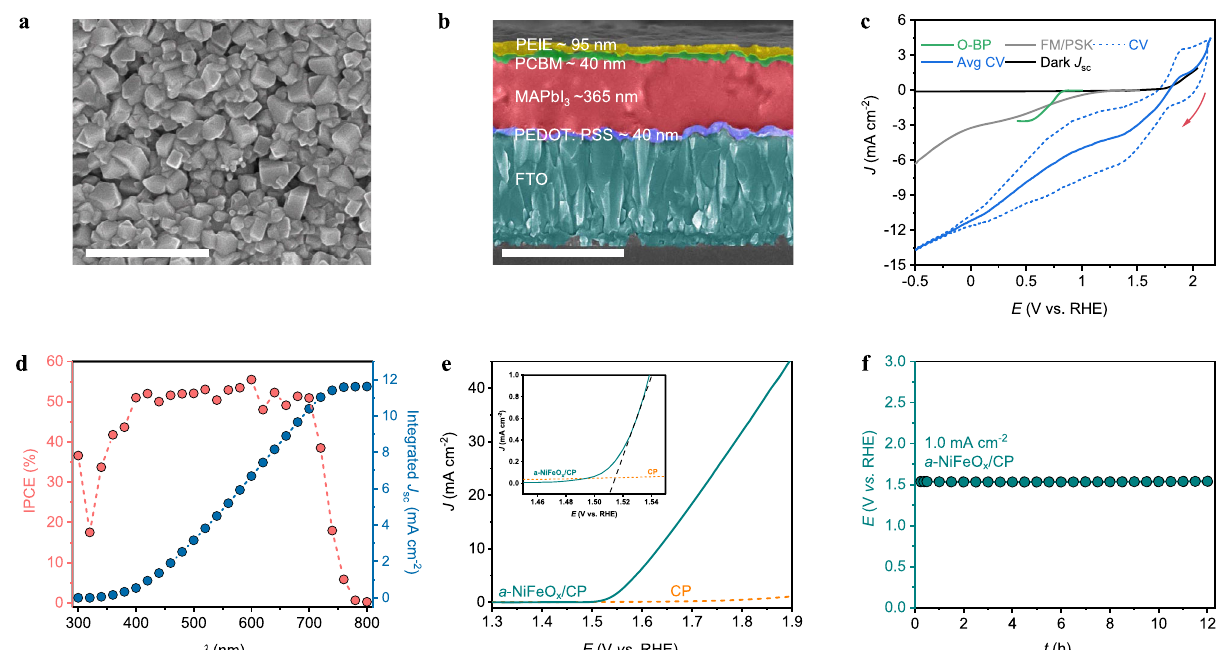
Fig. 3 Characterisation and ORR activity of the O-BP-integrated PSK photocathode. a , b Top-view and cross-sectional scanning electron micrographs of the formed MAPbI 3 PSK showing the thickness of the individual layers. c J – E responses of the O-BP electrocatalyst, Field ’ s metal (FM)/PSK photocathode, and integrated O-BP/FM/PSK photocathode device, exhibiting an anodic shift. Integrated O-BP/FM/PSK photocathode devices were simulated under 1-sun and an air mass of 1.5 G, with the averaged cyclic voltammograms (Avg. CV) scans under light and no irradiation (red arrow indicates the scan direction during the experiment) in the presence of an O 2 supply. d Wavelength-dependent spectral response (i.e., incident-photon-to-current ef fi ciency (IPCE)) and the corresponding integrated photocurrent density of the integrated device at 0 V vs. RHE. e J – E response of the a -NiFeO x /CP anode without stirring. Inset depicts the exact overpotential for the OER. f Chronopotentiometry test of the a -NiFeO x /CP anode conducted in a three-electrode set-up. c – f Experiments conducted in a 0.1 M KOH solution (pH ~13.17) under ambient conditions with a scan rate of 5 mV s − 1 . All scale bars equal 1 µ